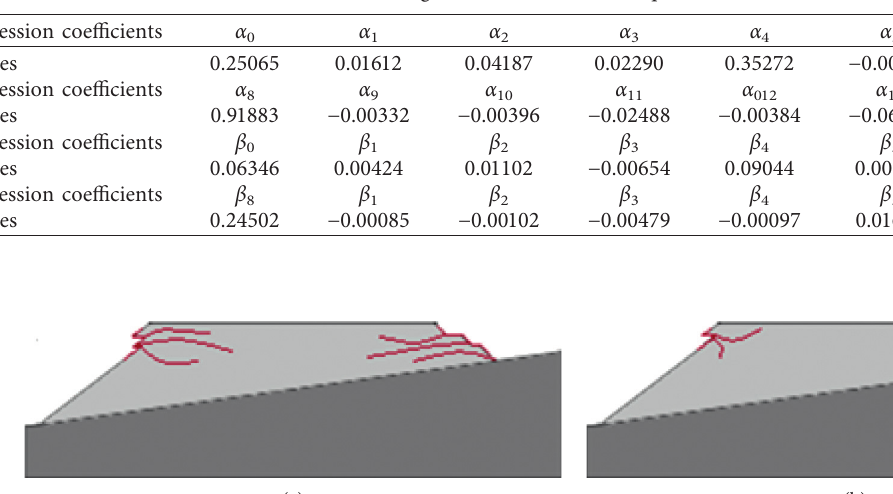
Table 6: Regression coefficients of equations (7) and (8).